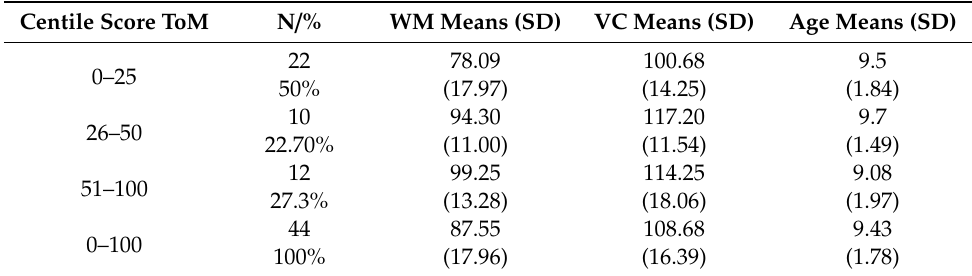
Table 1. Descriptive data on the distribution of participants in relation to the centile score achieved in Theory of Mind (ToM), and the means and standard deviations of working memory (WM), verbal comprehension (VC), and chronological